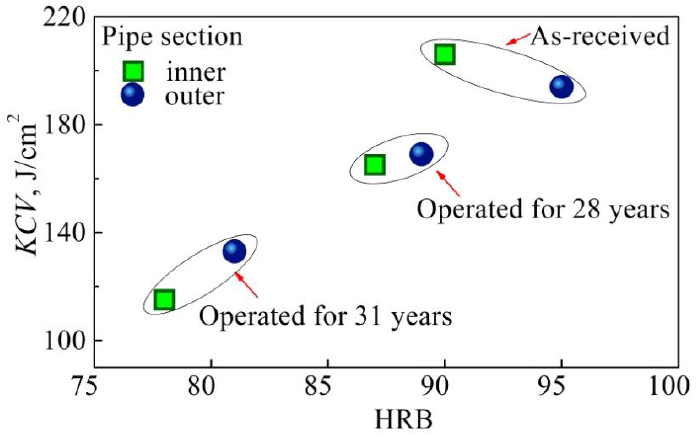
Figure 16. Relationship between hardness HRB and impact toughness KCV of the 17H1S steel.